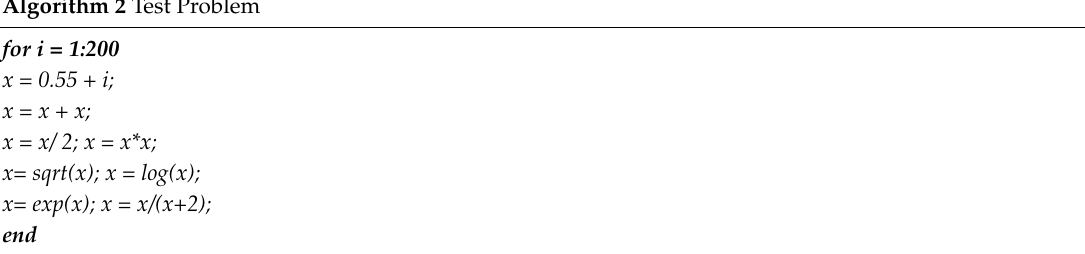
Algorithm 2 Test Problem